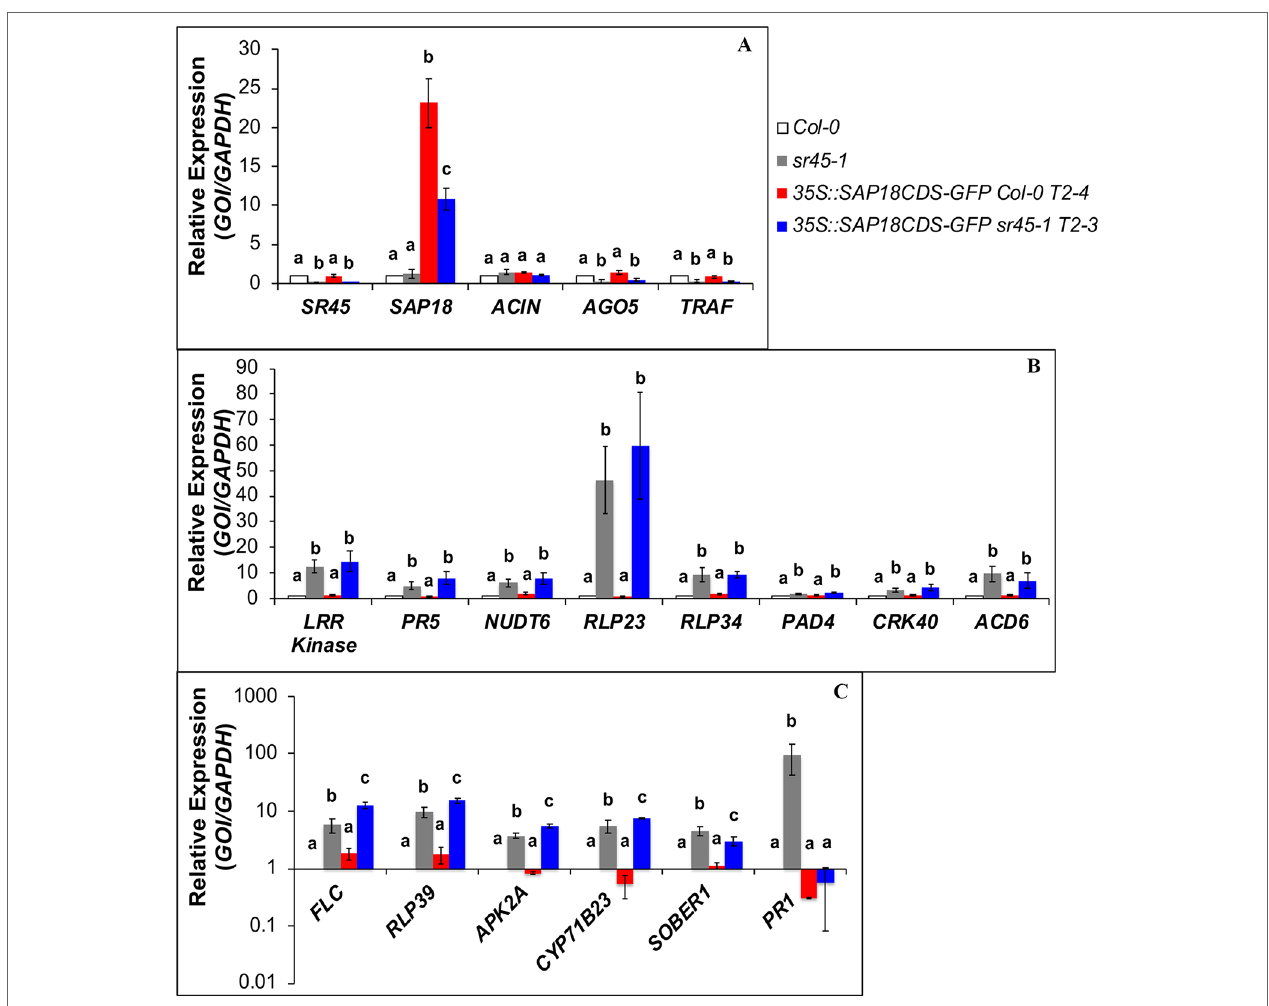
FIGURE 4 | RT-qPCR on SDR genes in Col-0, sr45-1, 35S::SAP18CDS-GFP Col-0 and 35S::SAP18CDS-GFP sr45-1. (A) SR45-upregulated genes; (B) SR45- downregulated genes that are not affected by SAP18-GFP overexpression; (C) SR45-downregulated genes that are affected by SAP18-GFP overexpression. One- way ANOVA followed by Tukey HSD was used for statistical analysis. Letters a–c represent different levels of statistical significance with p < 0.05. n = 3. Error bars represent standard